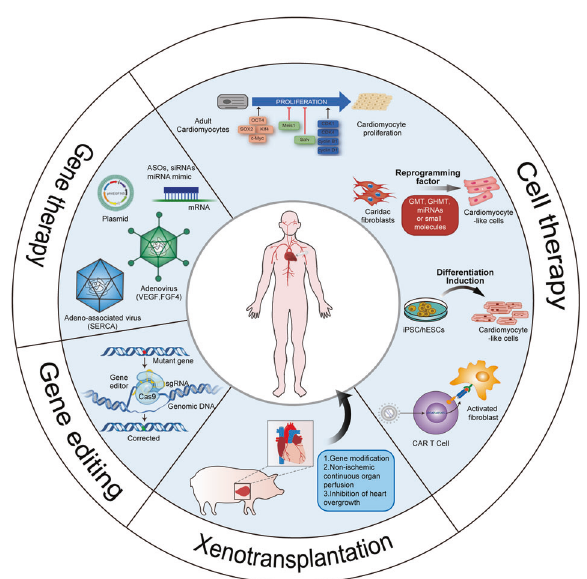
Fig. 4 Emerging therapeutic strategies to treat failing hearts. Gene therapy via various vectors enables direct manipulation of gene expression. Cell therapy is aimed at replacing the lost functional cardiomyocytes either exogenously or endogenously. Chimeric antigen receptor (CAR) T cell therapy is also proposed to ameliorate cardiac fi brosis and improve cardiac function. Xenotransplantation technique makes pig-to-human heart transplantation possible by overcoming multiple cross-species barriers. Clustered regularly interspaced short palindromic repeats CRISPR)/CRISPR-associated 9 (Cas9) based gene editing has the potential for curing inherited cardiomyopathy in the future. CDK: cyclin-dependent kinase; GTM (H): Gata4, Mef2c, and Tbx5 (Hand2); iPSC: induced pluripotent stem cell; hESC: human embryonic stem cell; CAR T-cell: Chimeric Antigen Receptor T-Cell; sgRNA: small guide RNA; VEGF: vascular endothelial growth factor; FGF4: fi broblast growth factor 4; ASO: antisense oligonucleotide; SERCA: sarco/endoplasmic reticulum Ca2 + −